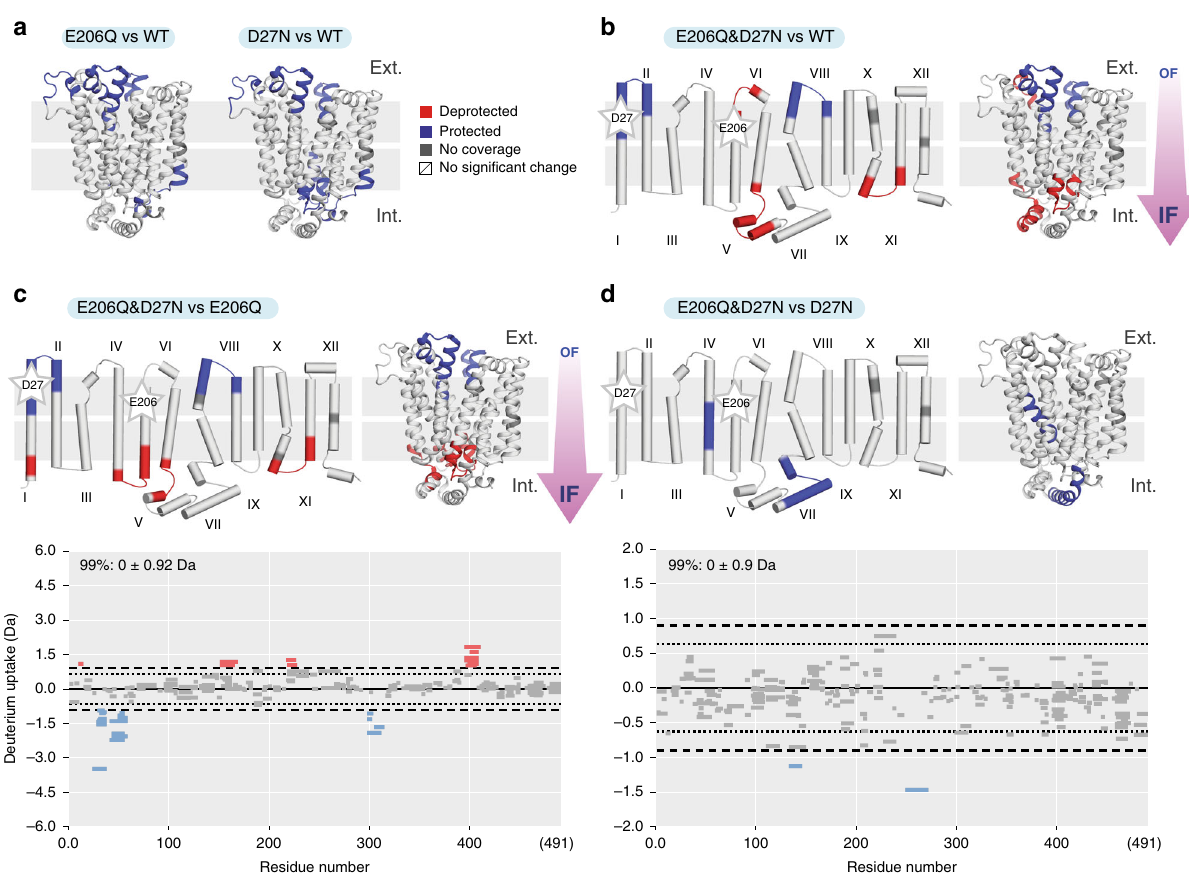
Fig. 2 Conformational change of XylE through mutation (protonation mimic). a Differential uptake pattern ( Δ HDX) map comparing XylE E206Q or D27N mutants to the WT. b Δ HDX map between XylE E206Q&D27N and WT state. c Δ HDX map and woods plot between XylE E206Q&D27N and XylE E206Q. d Δ HDX map and Woods plot between XylE E206Q&D27N and XylE D27N. Each bar on Woods plots represents a single peptide with peptide length indicated by the bar length. Figures are projected onto topological and 3D protein structure (PDB: 4GBY) using PyMol. Blue and red regions indicate a negative (protected) and a positive (deprotected) deuterium uptake difference, respectively. Mutated residues are indicated by a